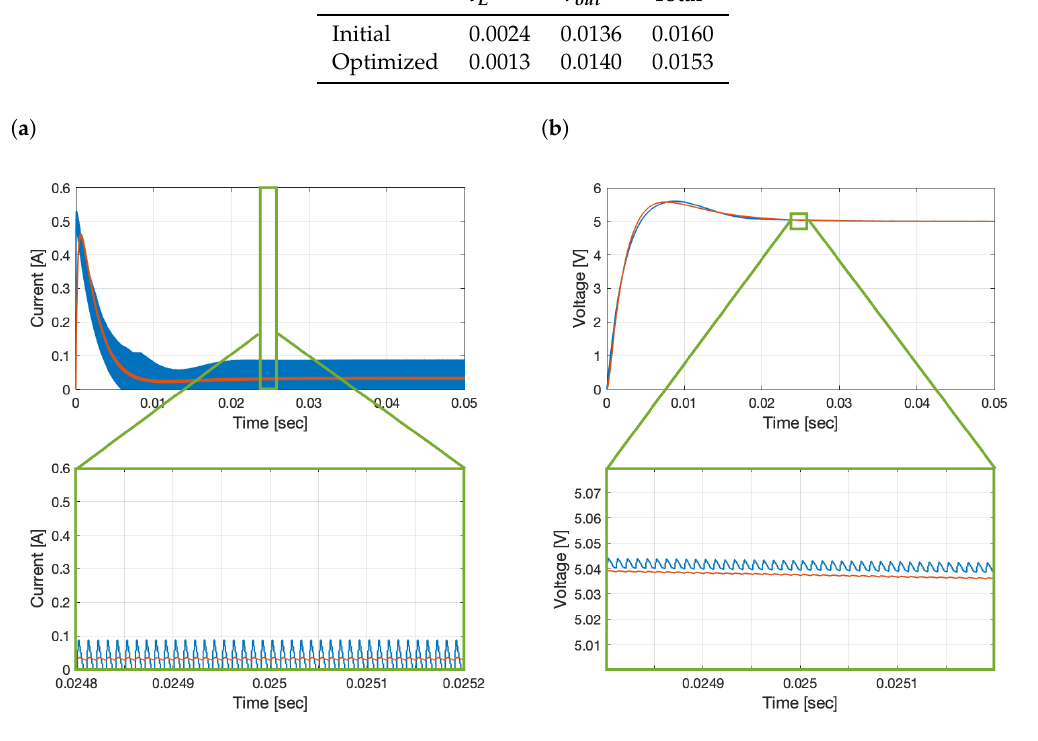
Figure 19. ( a ) Inductor current and ( b ) output voltage response with a 150 [ Ω ] load.